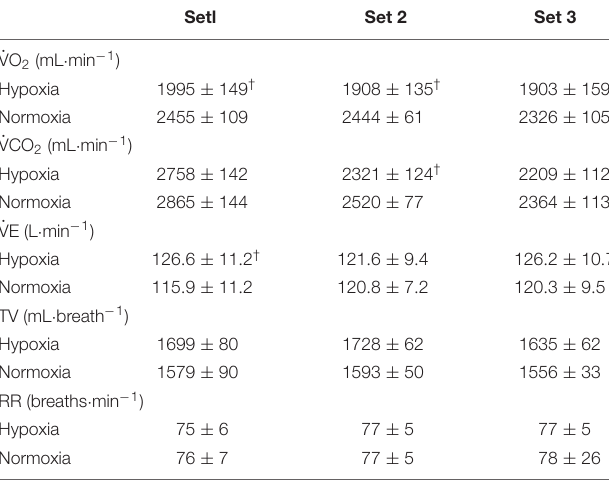
TABLE 1 | Oxygen uptake ( ˙ VO 2 ), carbon dioxide production ( ˙ VCO 2 ), minute ventilation ( ˙ VE), tidal volume (TV), and respiratory rate (RR) during double-poling sprint exercise.